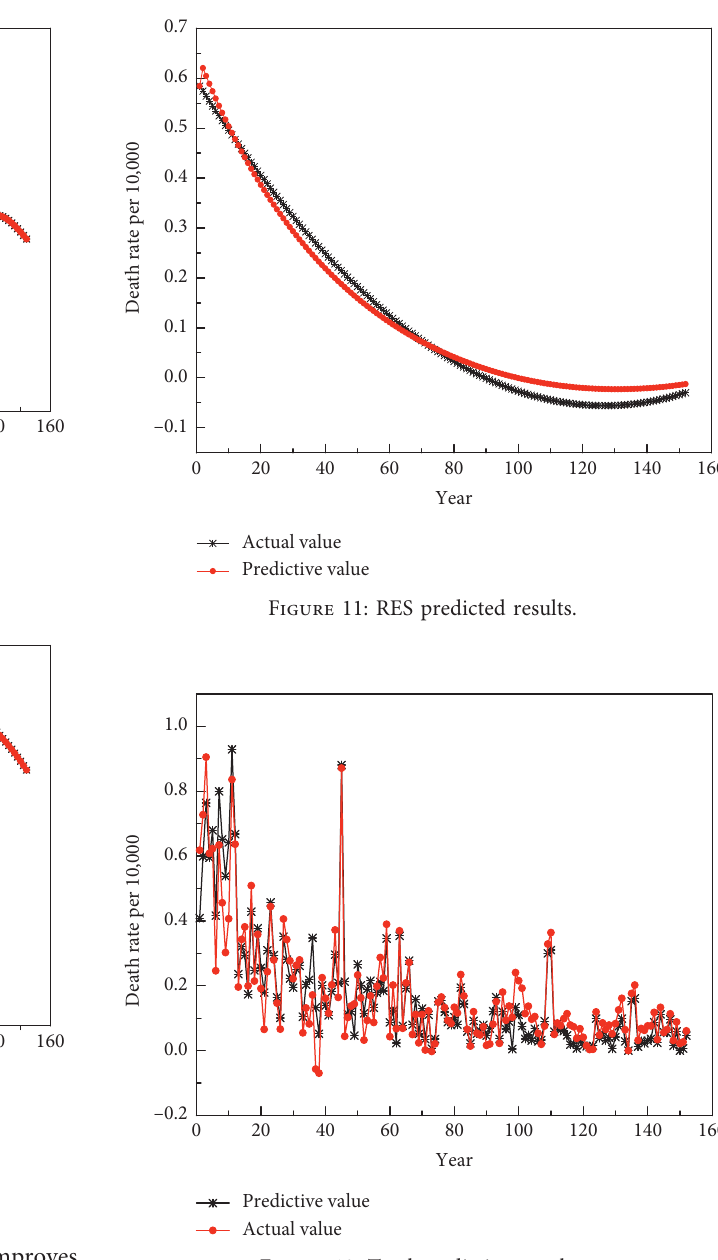
Figure 12: Total prediction